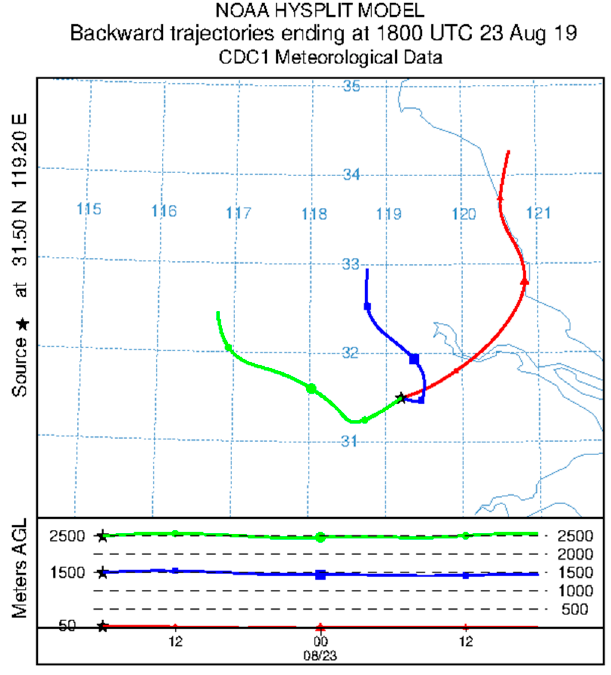
Figure A3. Same as Figure A2, but for 19 August 2019.